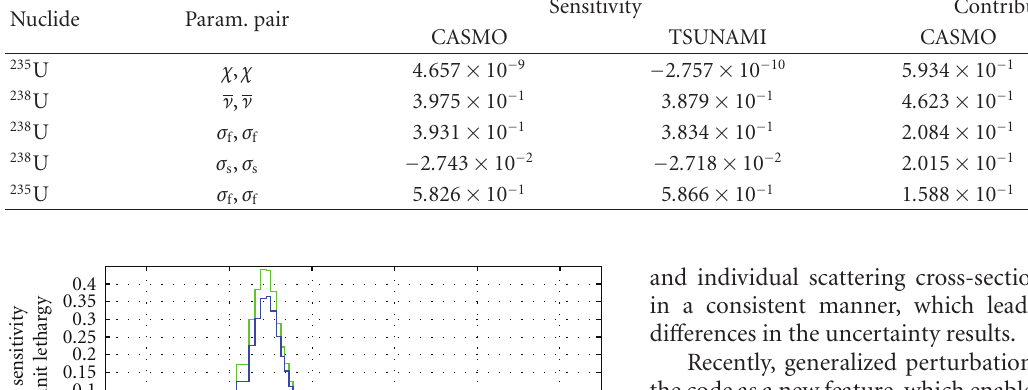
Table 6: The five most significant sources of uncertainty for the response ν Σ f,1 and the corresponding energy- and region-integrated relative sensitivity coe ffi cients. The sensitivity coe ffi cients with respect to the parameter χ have been constrained. Sensitivity Nuclide Param. pair